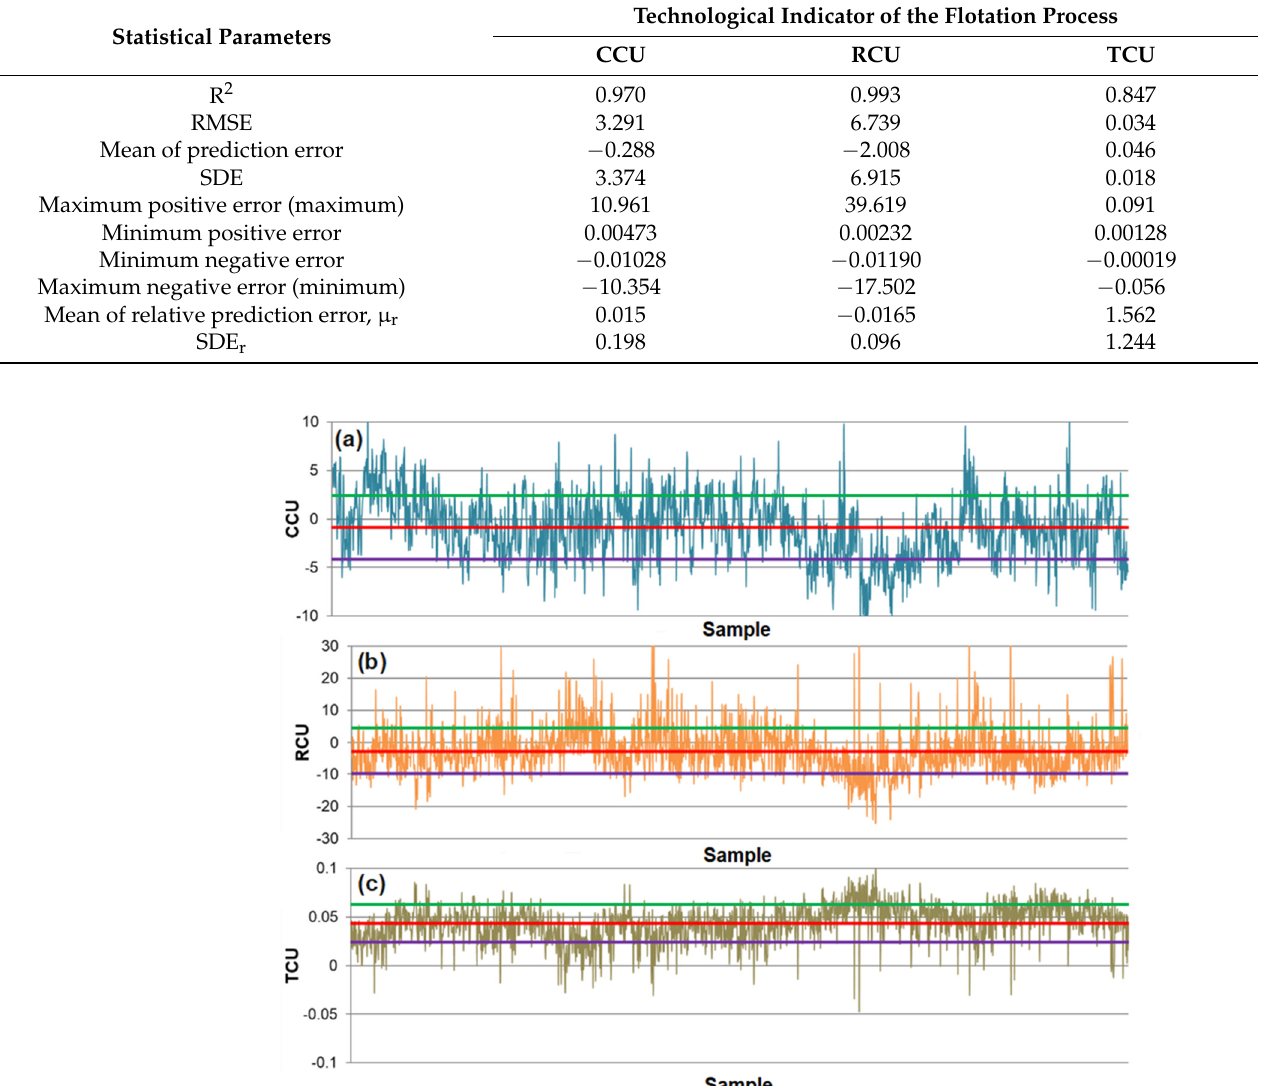
Table 9. Statistical analysis of actual and predicted values using the PSM model.